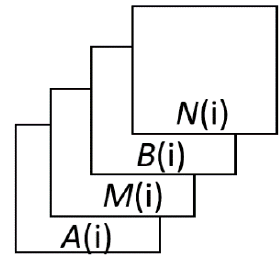
Figure 2. The form of R ( i ).